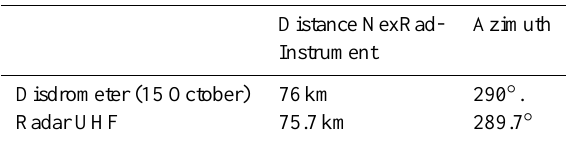
Table 3. Mean values of the distance and azimuth between the NexRad radar et and the other instruments, disdrometer and UHF